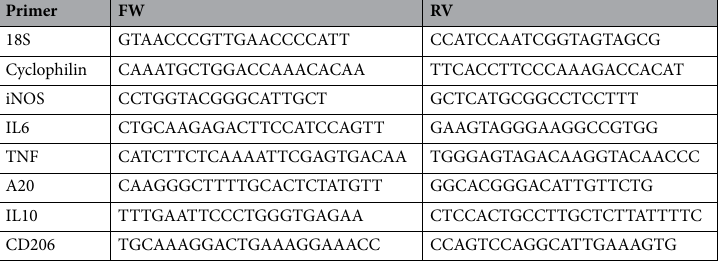
Tables 1, 2, Supplemental tables